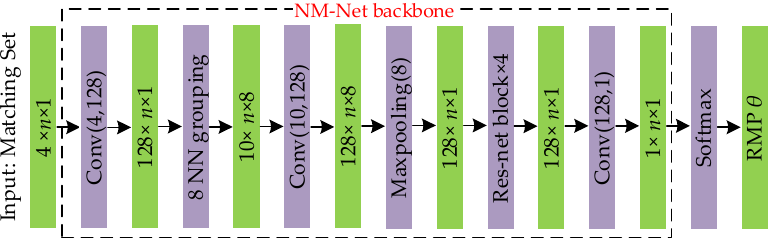
Figure 3. Network architecture used in ULMR. Conv( i , o ) represents a convolutional operation with additional operations such as batch normalization and activation, the input data has i channels, and the output data has o channels; Res-Net block × 4 represents four residual connected convolutional networks; Maxpooling( i ) represents a max pooling operation with inputted data that has i channels; and 8NN grouping mines eight nearest neighbors’ information in a hierarchical structure.